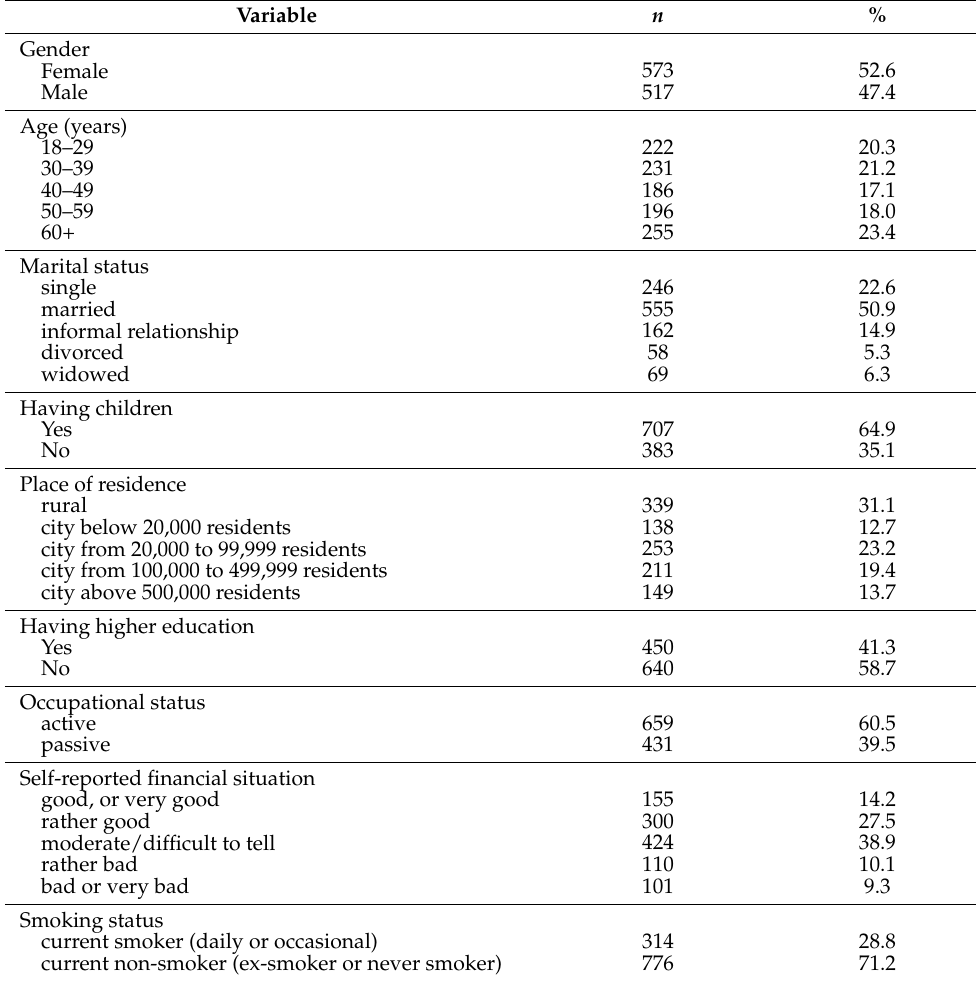
Table 1. Characteristics of the study population ( n =